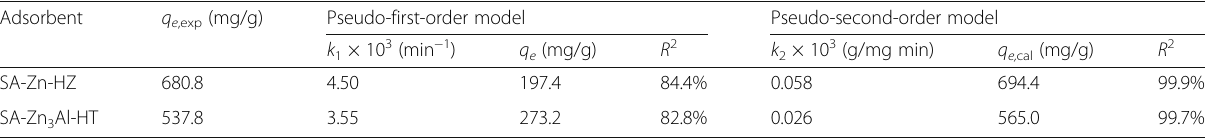
Table 3 The pseudo-first-order and pseudo-second-order kinetic model parameters for the adsorption of Pb(II) on SA-Zn-HZ and SA-Zn 3 Al-HT Adsorbent q e ,exp (mg/g) Pseudo-first-order model